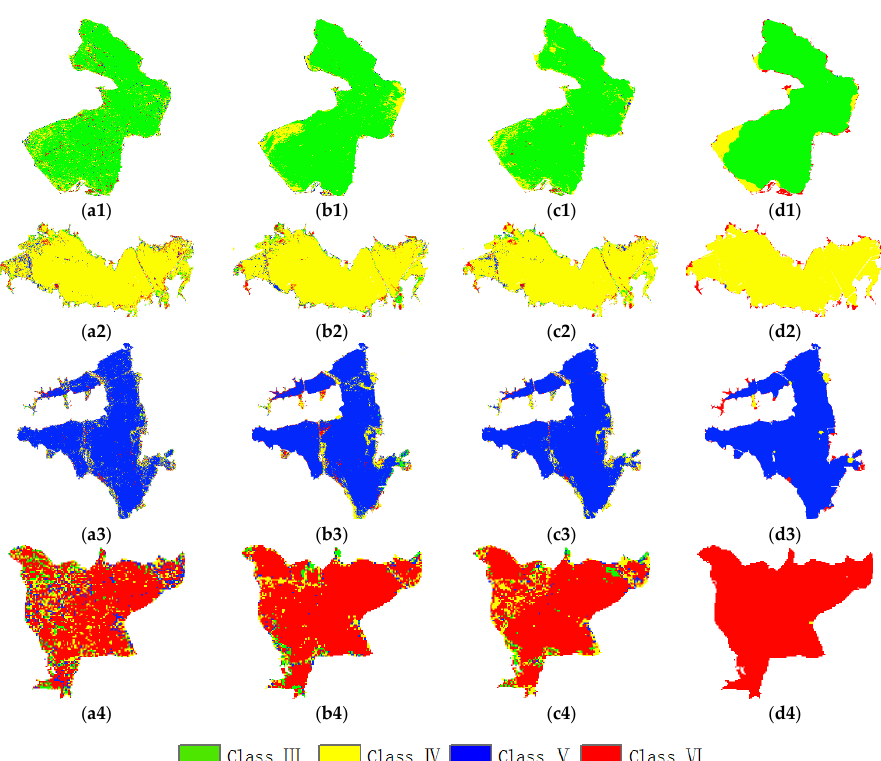
Figure 6. The classification result maps of the water quality levels for the Huangshi dataset: ( a1 – a4 ) DT; ( b1 – b4 ) DNN; ( c1 – c4 ) RF; ( d1 – d4 ) RF-CRF; (1) Class III Taibai Lake; (2) Class IV Daye Lake; (3) Class V Baoan Lake; (4) Class VI Haikou Lake.